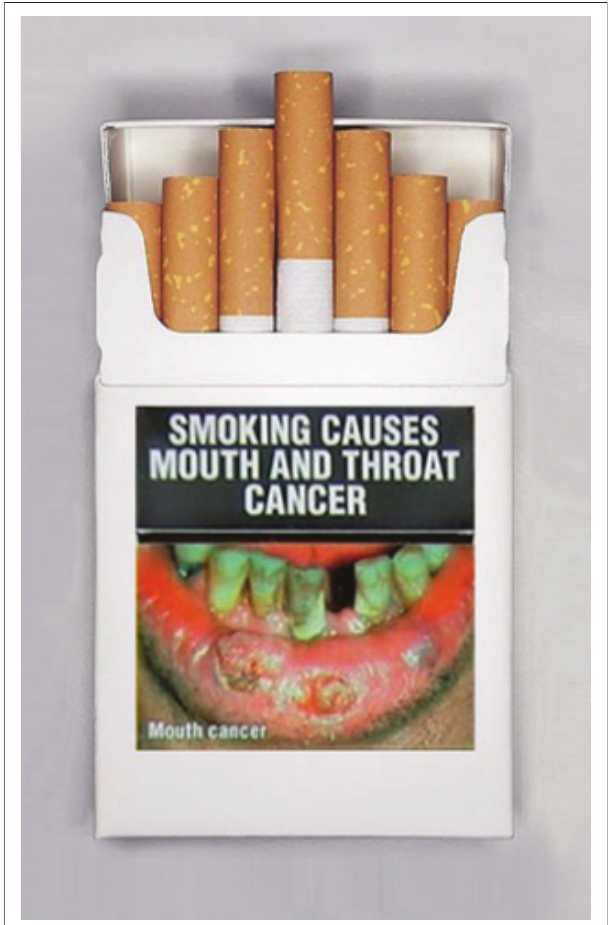
FIGURE 4: Both text and picture-based warning: A mouth with a tooth missing, several damaged teeth and cancerous sores on the lower